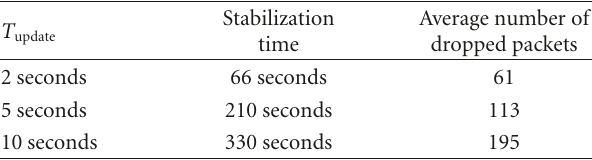
Table 4: Packet drops information with di ff erent T update .